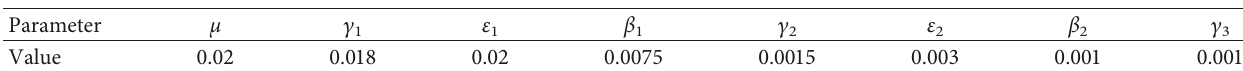
Figure 5: Hardware system and experimental area. Table 2: Control